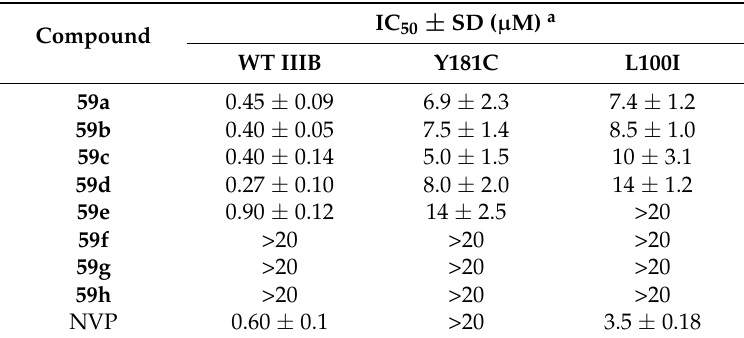
Table 6. Anti-HIV-1 activity of PAS 59a – h against the rRT.